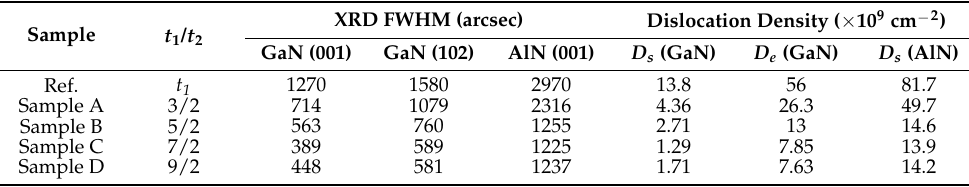
Table 1. The full-width-at-half-maximum (FWHM) values of the X-ray diffraction (XRD) rocking curve and calculated dislocation densities for all the